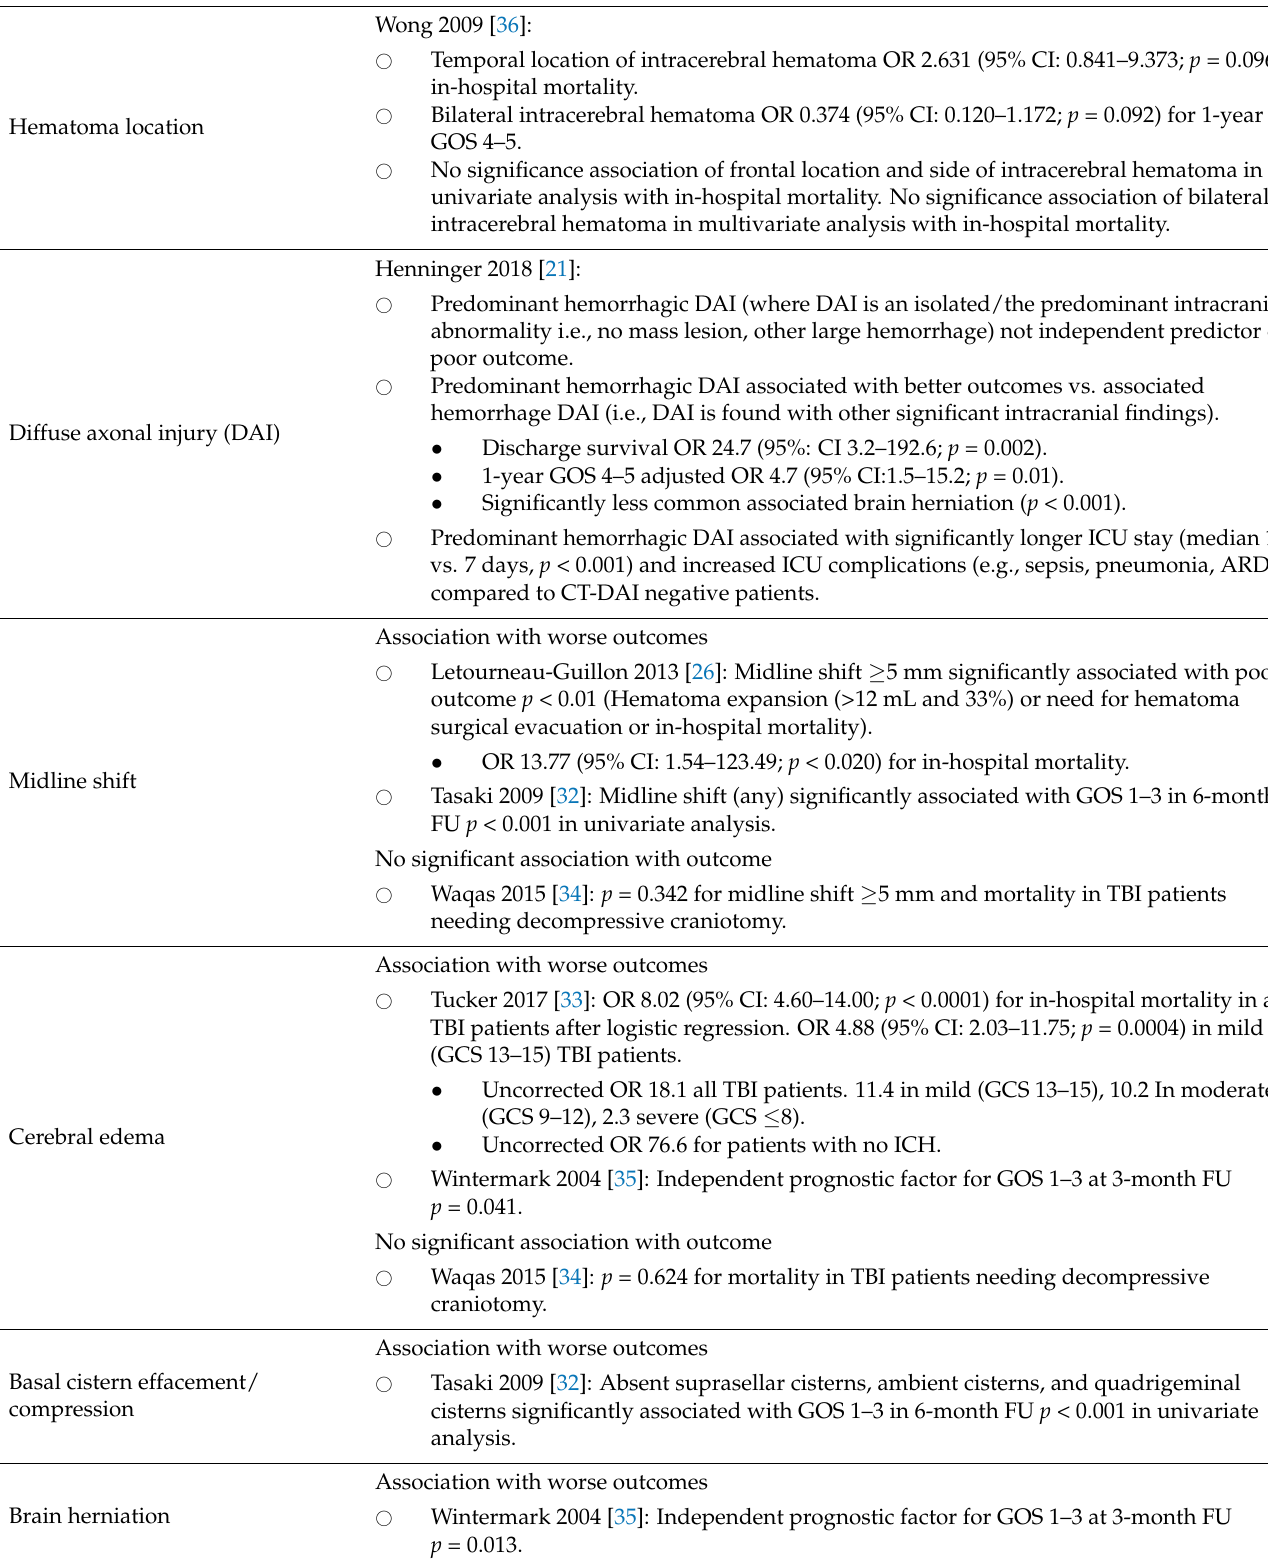
Table 2. Cont. Imaging Finding Relationship with Patient